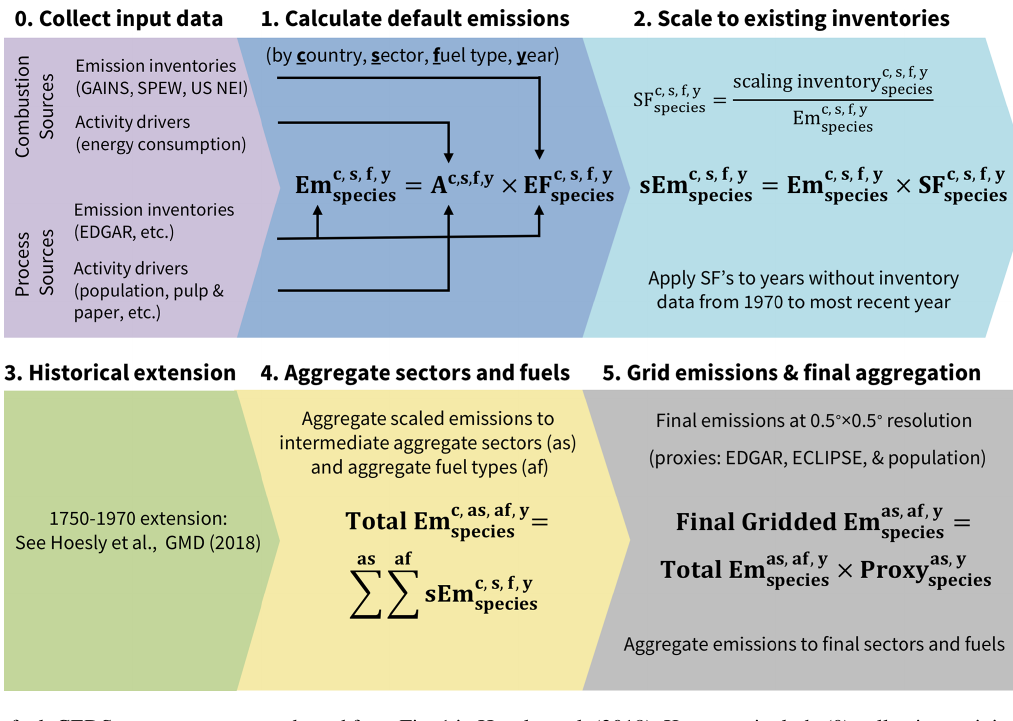
Figure 1. Default CEDS system summary, adapted from Fig. 1 in Hoesly et al. (2018). Key steps include (0) collecting activity driver ( A ) and emission factor (EF) input data for non-combustion and combustion emission sources; (1) calculating default emissions (Em) as a function of chemical species, country, emission sector, fuel type, and year; (2) calculating scaling factors (SFs) for overlapping years with existing inventories in order to scale default estimates (sEm) and extending SFs for non-overlapping years between 1970–2017 (for earlier emissions, see Hoesly et al., 2018); (4) aggregating scaled emissions to intermediate sectors and fuel types; and (5) using source- and compound-specific spatial proxies to calculate final gridded emissions and aggregate them to the final sectors and fuels. A list of intermediate and final sectors and fuels are in Table 2.